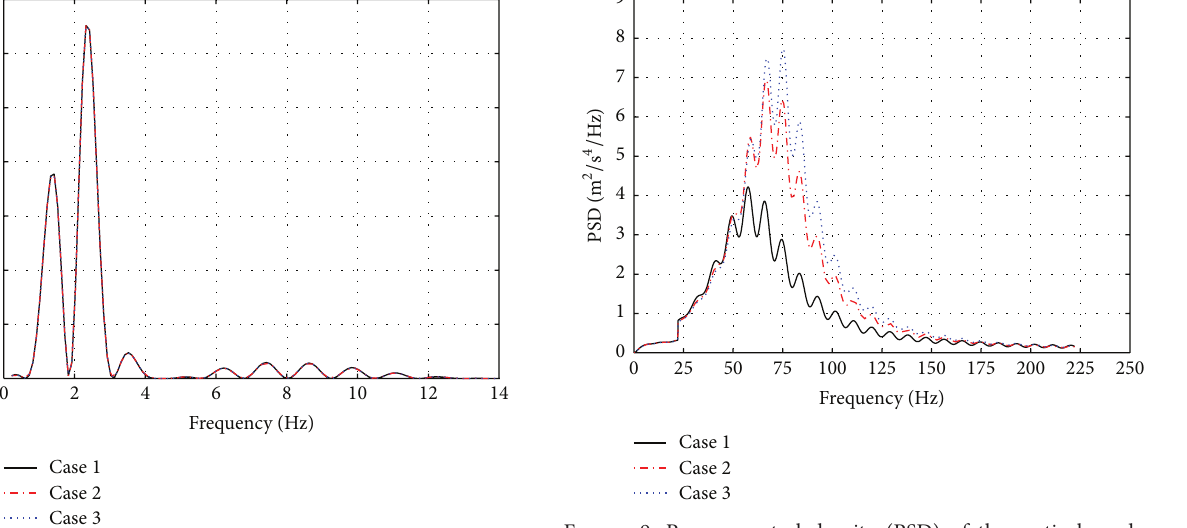
Figure 7: Power spectral density (PSD) of the vertical random vibration acceleration of a vehicle body due to the linear secant stiffness, the nonlinear frequency-dependent stiffness, and the non- linear amplitude- and frequency-dependent stiffness of rail pads.